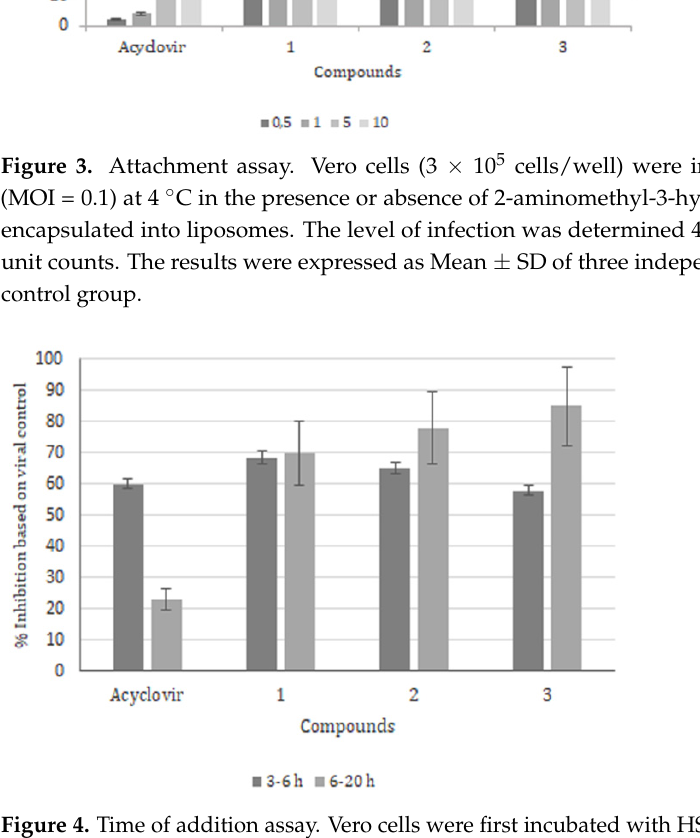
Figure 4. Time of addition assay. Vero cells were first incubated with HSV-1 (MOI = 0.1) for 1 h, then acyclovir (12.6 μ M), compound 1 (6.92 μ M), 2 (2.24 μ M) and 3 (1.44 μ M) were added at different incubation times, as indicated. The level of infection was determined 48 h later by plaque-forming unit counts. The results are expressed as Mean ± SD of three independent experiments. p < 0.05 control group.